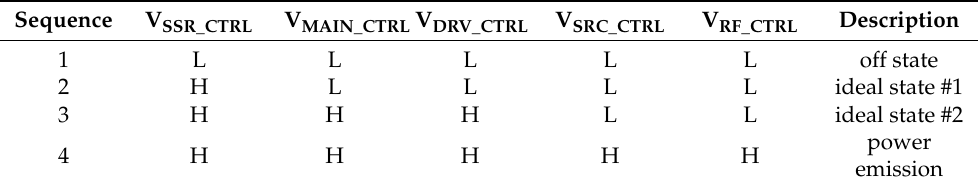
Table 2. Operating sequence for the proposed RF source